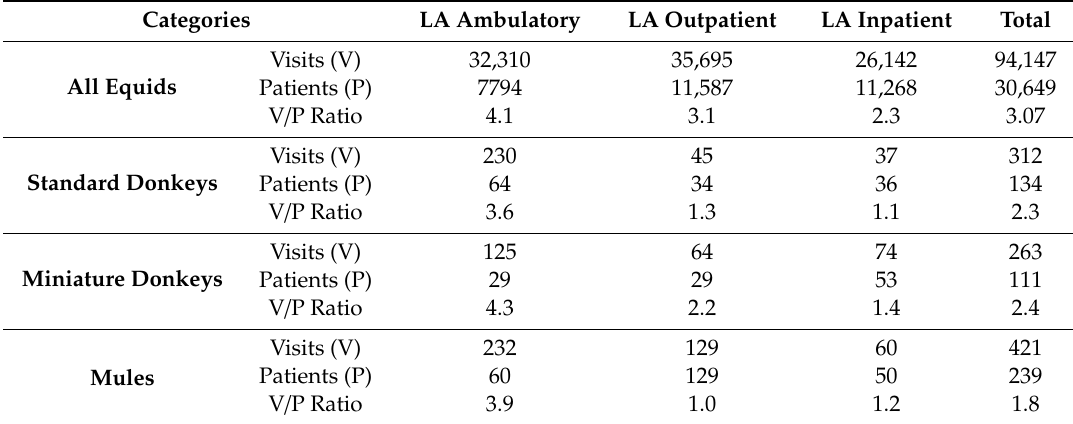
Table 1. Ratio of Number of Visits per Patient for Visit Types at the Large Animal